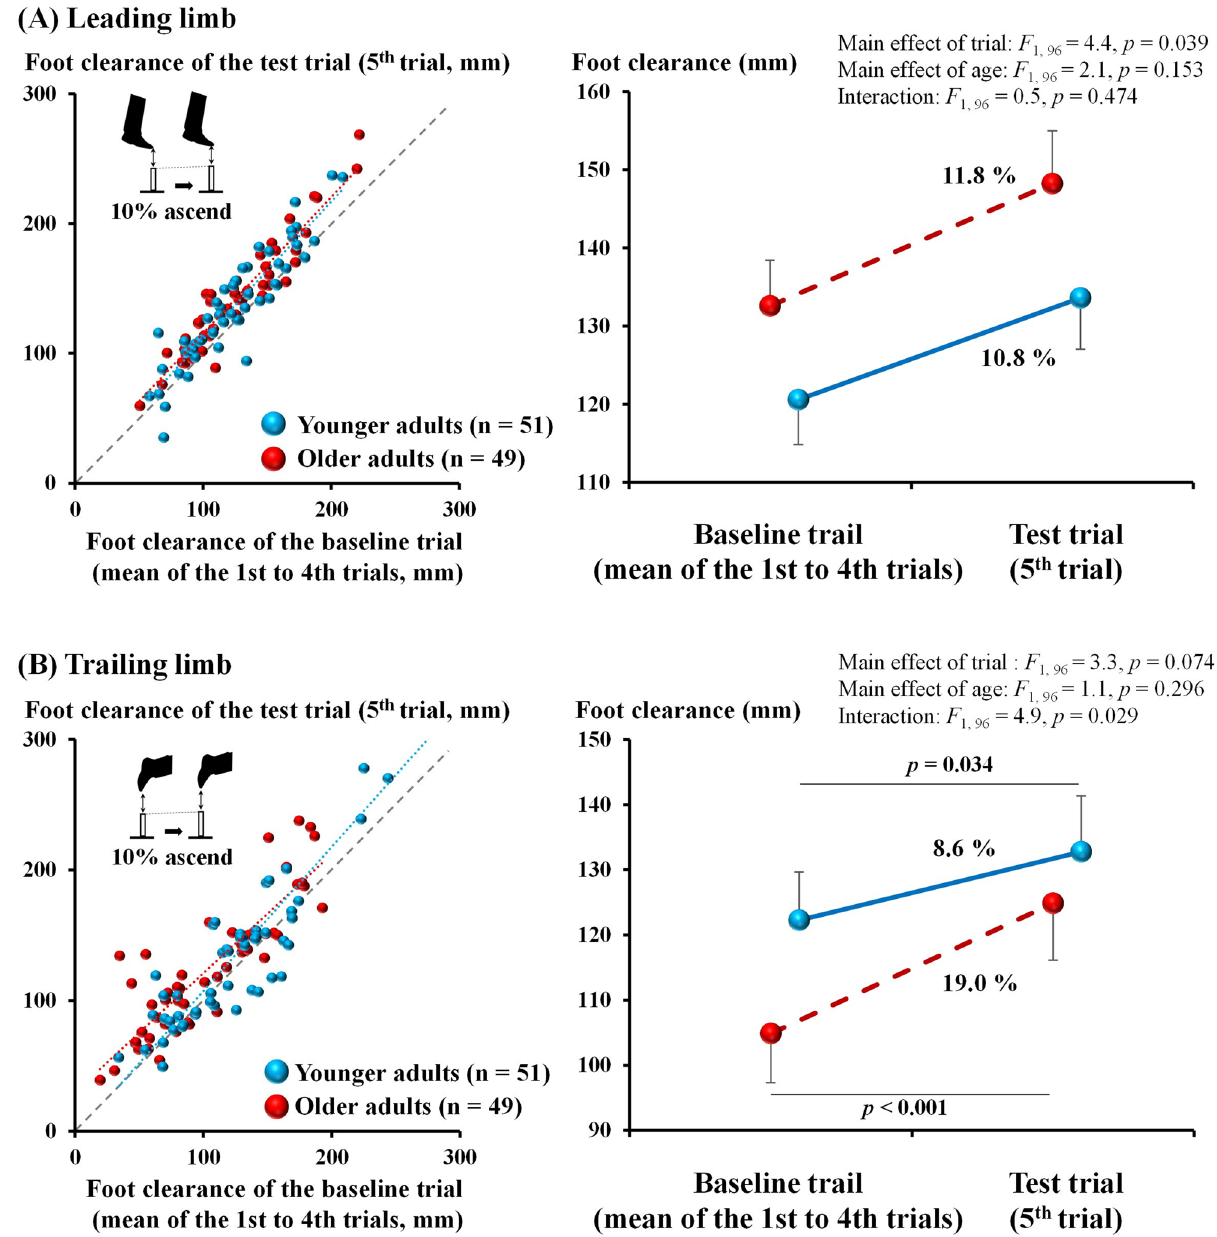
Figure 1. Comparison of the foot clearance in the ascending condition for the younger and older adults. Left side: scatter diagrams of the foot clearance of the baseline trial (mean of the 1st to 4th trials) and the test trial (5th trial) for the young and older adults. Data points above or below the diagonal line show participants who increased or decreased their foot clearance in the fifth trial. The light blue and red dashed lines indicate the regression lines of the young and older adults, respectively. Right side: line graphs of the foot clearance of the baseline trial (mean of the 1st to 4th trials) and the test trial (5th trial) for the young and older adults (error bars indicate standard errors). For both scatter and line diagrams, the upper scatter diagram ( A ) is for the leading limb and the lower scatter diagram ( B ) is for the trailing limb. Bars and error bars indicate adjusted mean actual values and standard ( p = 0.001) but not in older adults. The mean change in foot clearance in the test trial was 6.4% and 0.7% for the younger and older adults, respectively. Scatterplots for foot clearance of the trailing limb showed the same trend as the leading limb, although the plots were relatively scattered. Contrary to those of the leading limb, the two-factor mixed ANCOVA for log- transformed foot clearance found no significant main effects of the obstacle condition ( p = 0.568, η 2 = 0.003), age group ( p = 0.746, η 2 = 0.001), and interaction between the two factors ( p = 0.132, η 2 = 0.023).